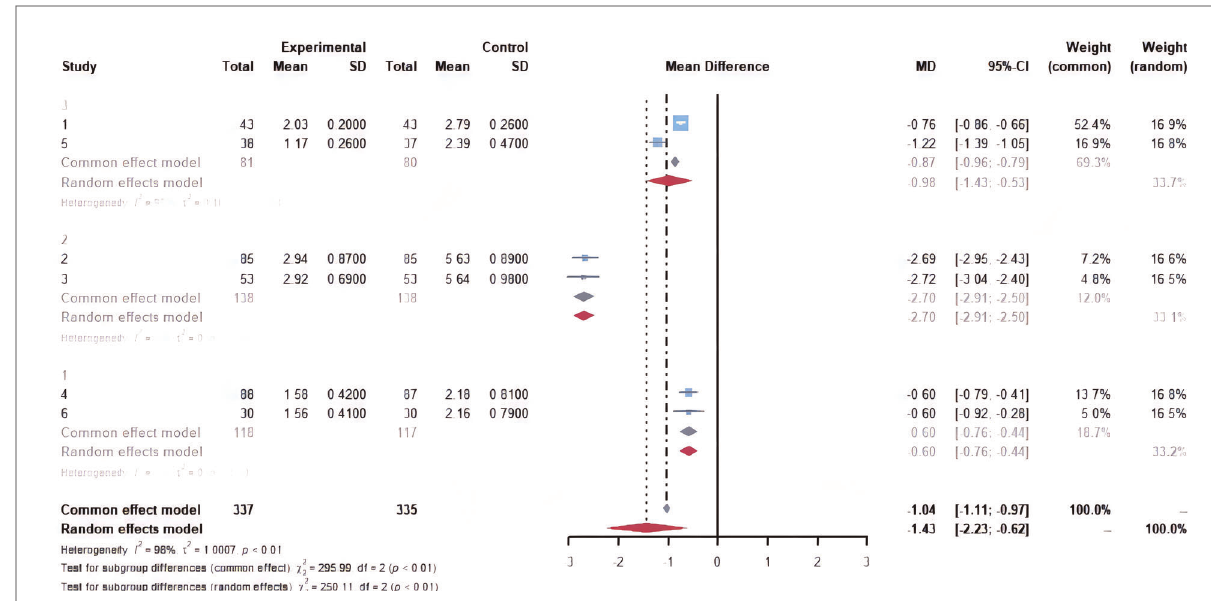
FIGURE 8 Subgroup analysis forest plot based on post-treatment visual analogue scale/score. Study 1 and 5: Jingtong yushu granule and Bushen Huayu decoction. Study 2 and 3 Gui ’ e lengwu decoction; study 4 and 6: Gui Zhi Fu Ling